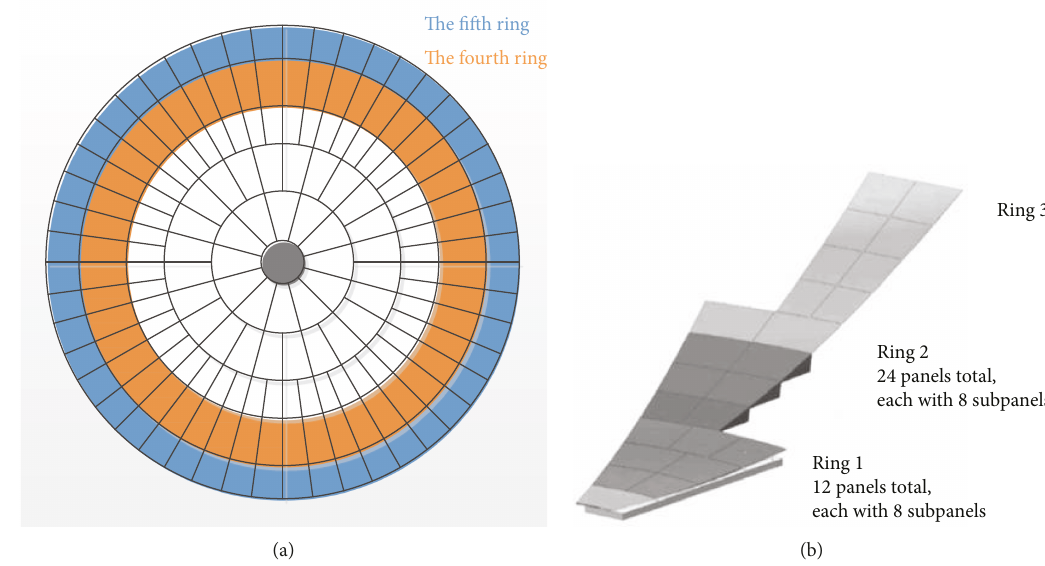
Figure 6: Segment design of LMT main surface. (a) Primary re fl ector of LMT; (b) panel layout for rings 1, 2, and